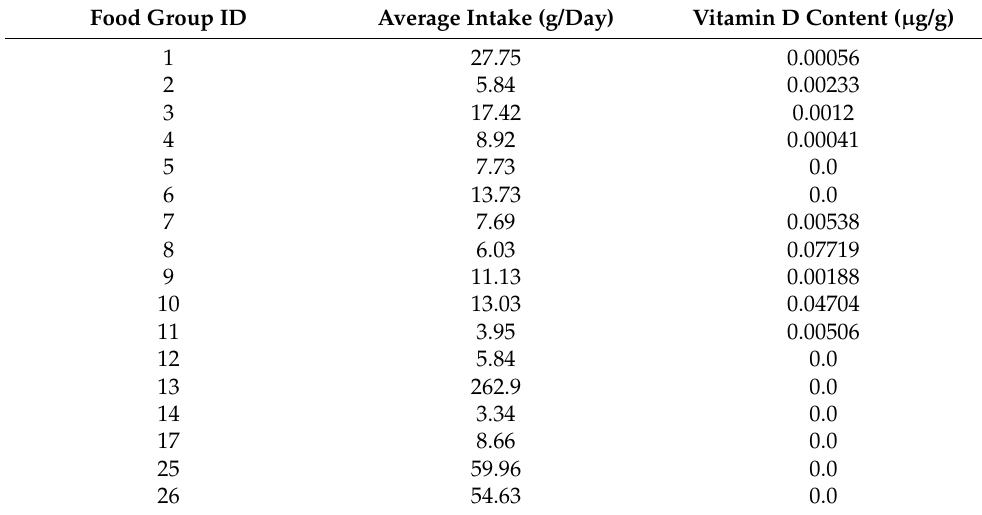
Table 3. Concentration composition chart. Vitamin D concentration for each food group is aggregated over all food items in the food group (without fortification)